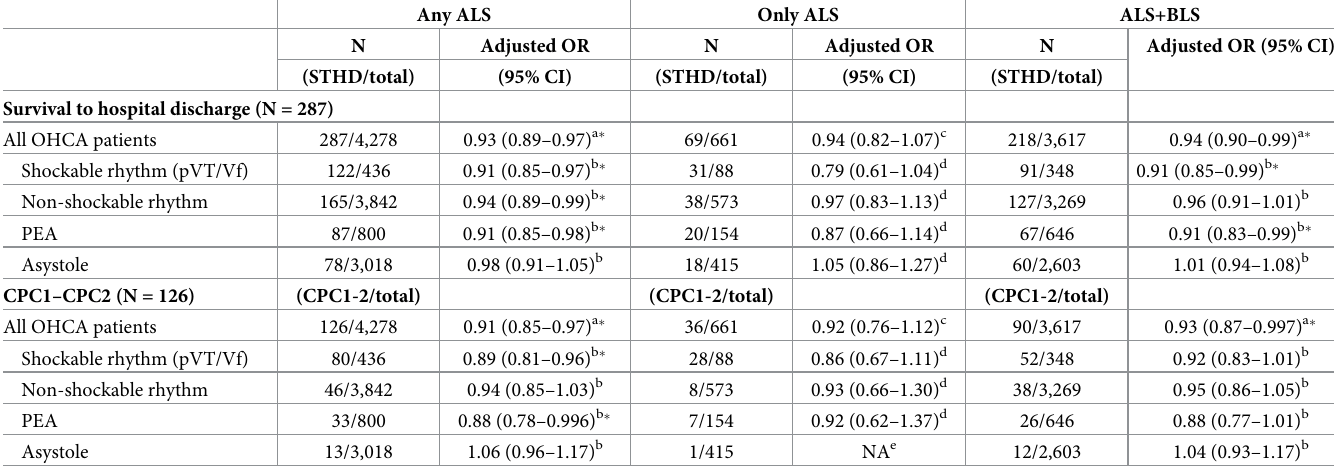
Table 2. Multivariable logistic regression of survival to hospital discharge and neurological outcome with predictor of each minute of ALS response time. Any ALS Only ALS ALS+BLS N Adjusted